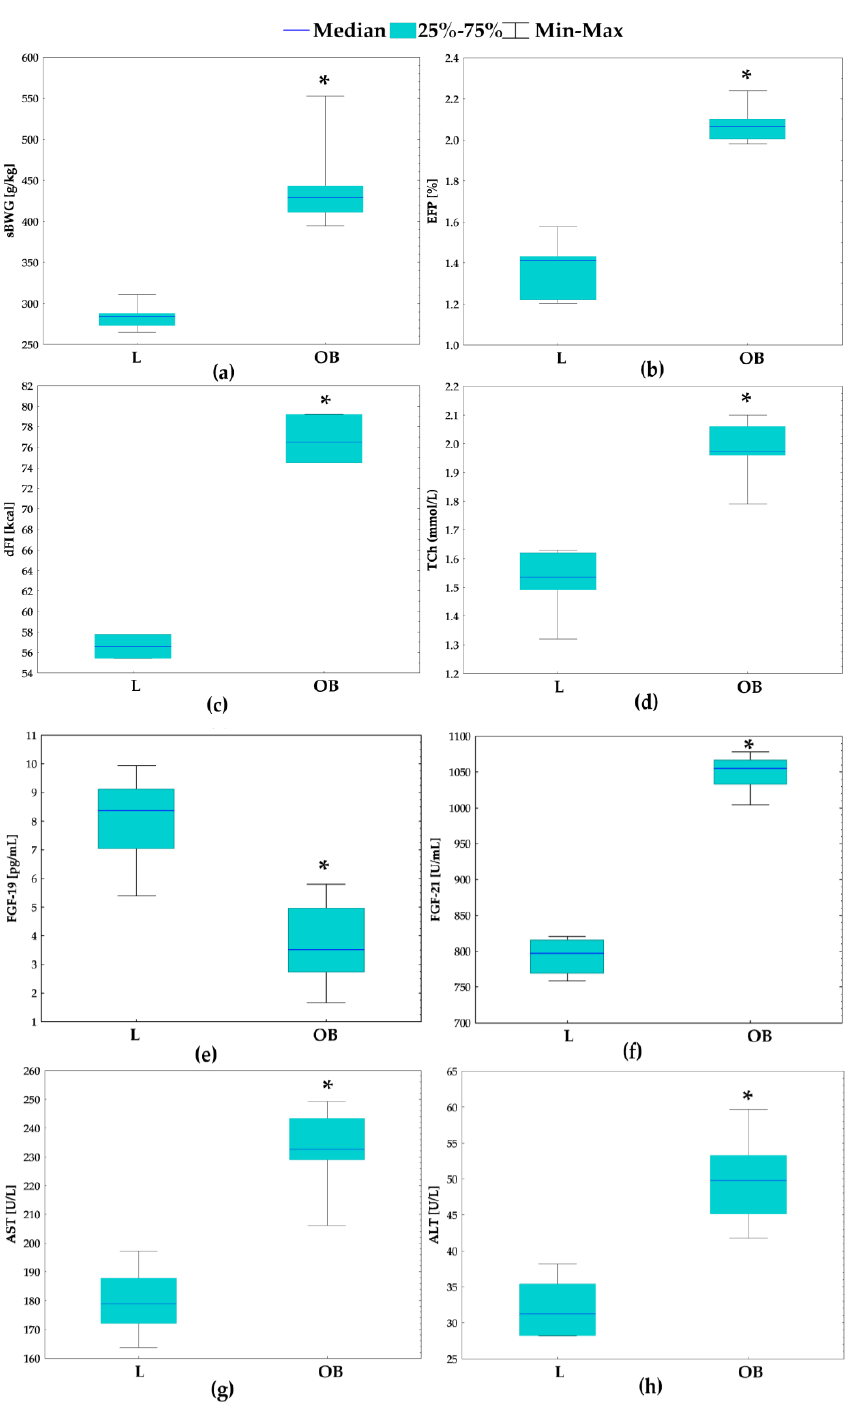
Figure 2. Pearson’s or Spearman’s correlation coefficients between physiological and metabolic pa- rameters. sBWG — specific rate of body weight gain, EFP — epididymal fat pads, dFI — daily feed in- take, TCh — total cholesterol, FGF-19 — fibroblast growth factor 19, FGF-21- fibroblast growth factor 21, AST — liver aspartate transaminase, ALT — liver alanine transaminase, All correlations are statis- tically significant (at the p -levels < 0.05).